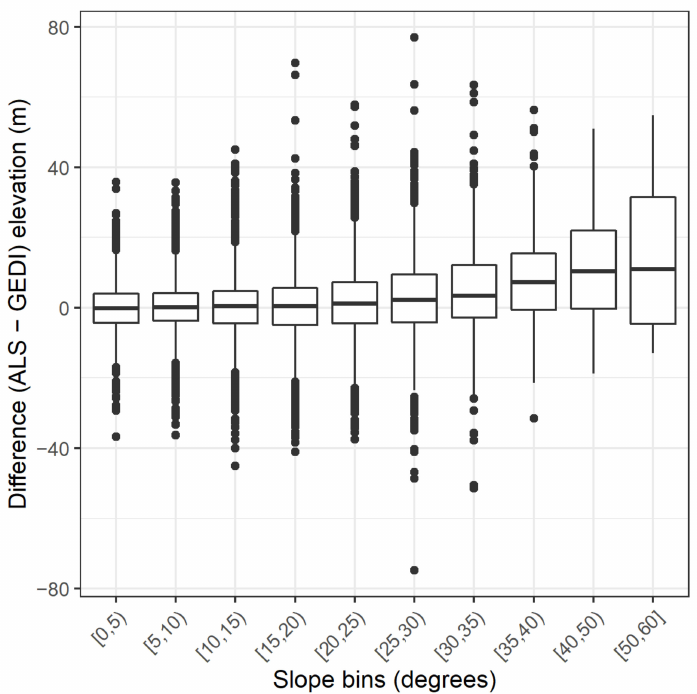
Figure 4. Boxplot of differences in elevation between ALS and GEDI i.e., (ALS 95 , GEDI 95 ) for individual footprints (11,832) in different slope